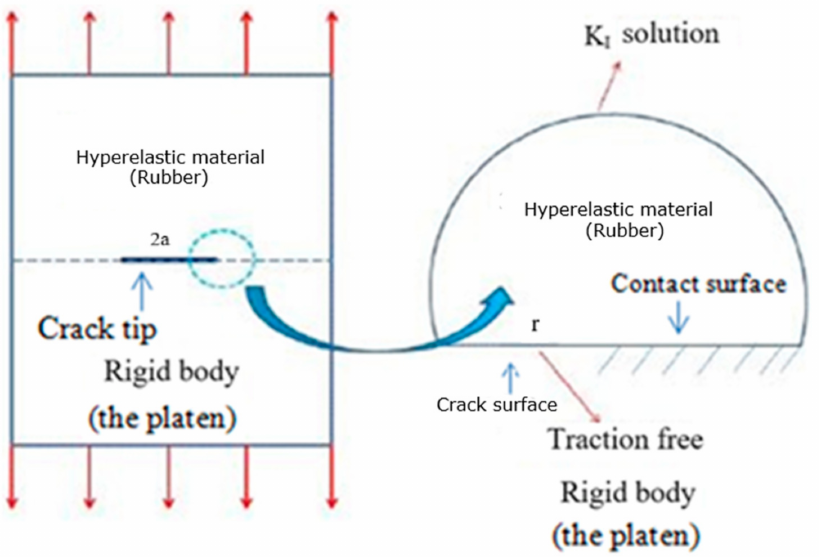
Figure 2. The semicircle with crack tip at center. Table 1. Material parameters of the